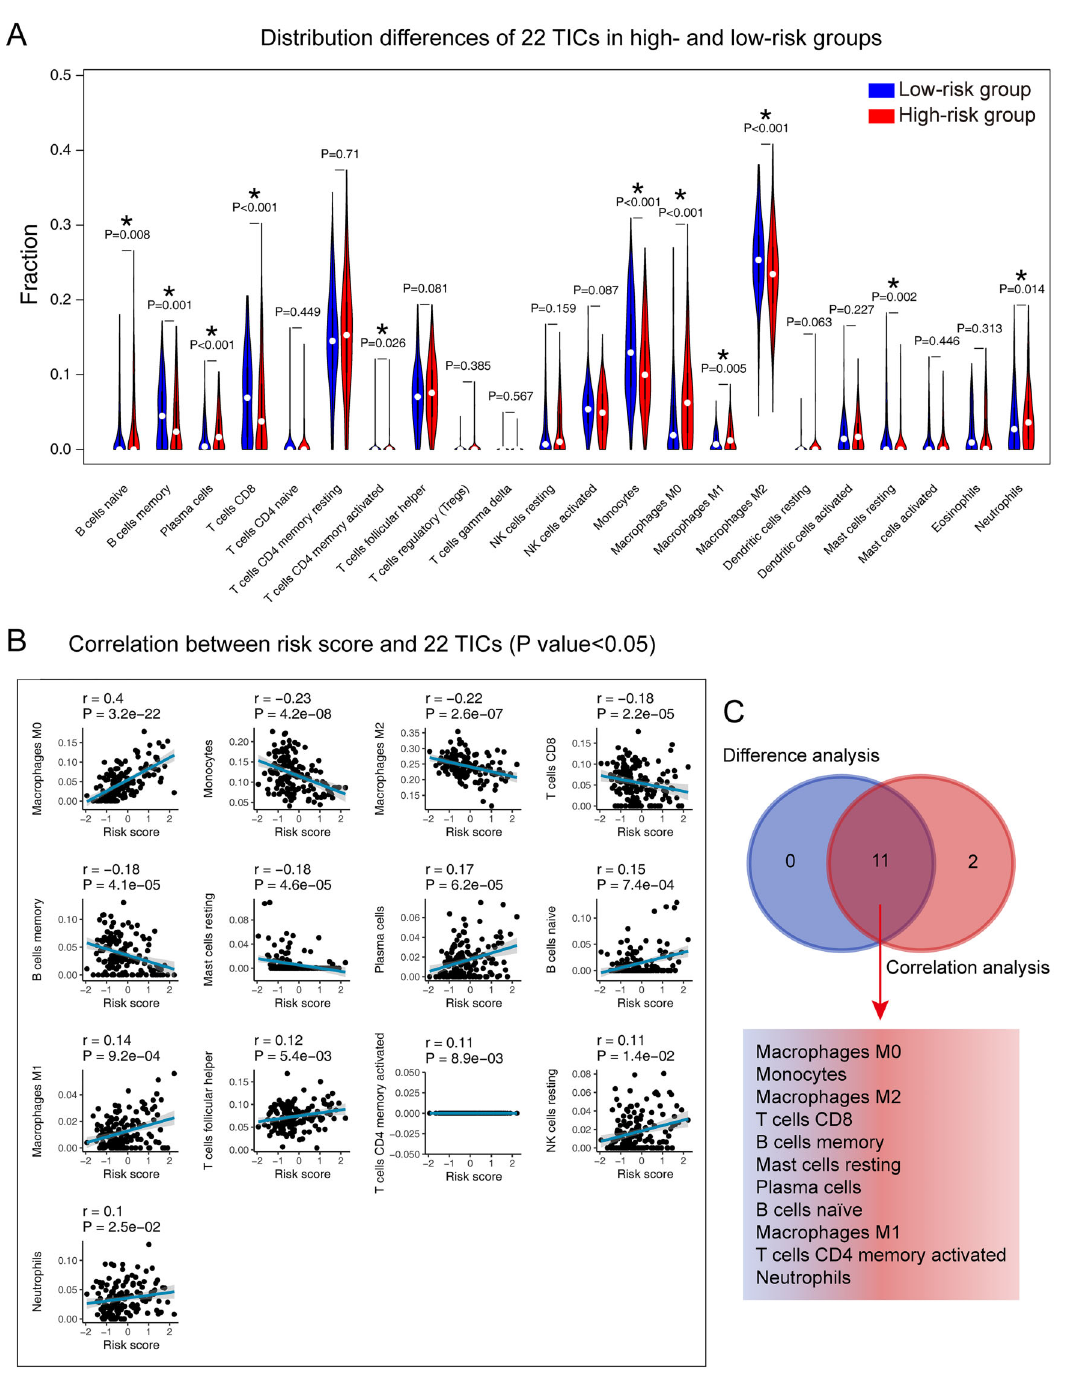
Figure 8. Correlation of TICs proportion with the eight-gene signature risk score in the Pediatric Brain Tumor Atlas (CBTTC) cohort (CIBERSORT method). A , Violin plot showing the ratio differentiation of 22 kinds of immune cells between PBT samples from low- and high-risk groups to the median risk score. Wilcoxon rank sum test was used to assess for signi fi cance. B , The blue line in each plot is the fi tted linear model indicating the proportion tropism of the immune cell with risk score. The shade around the blue line represents the 95% con fi dence interval. Spearman coef fi cient was used for the correlation test. C , Venn plot displayed 11 TICs correlated with risk score co-determined by difference and correlation tests shown in violin and scatter plots, respectively. P value o 0.05 was the cutoff. TIC: tumor-in fi ltrating immune cell; PBT: pediatric brain tumor. Braz J Med Biol Res | doi: